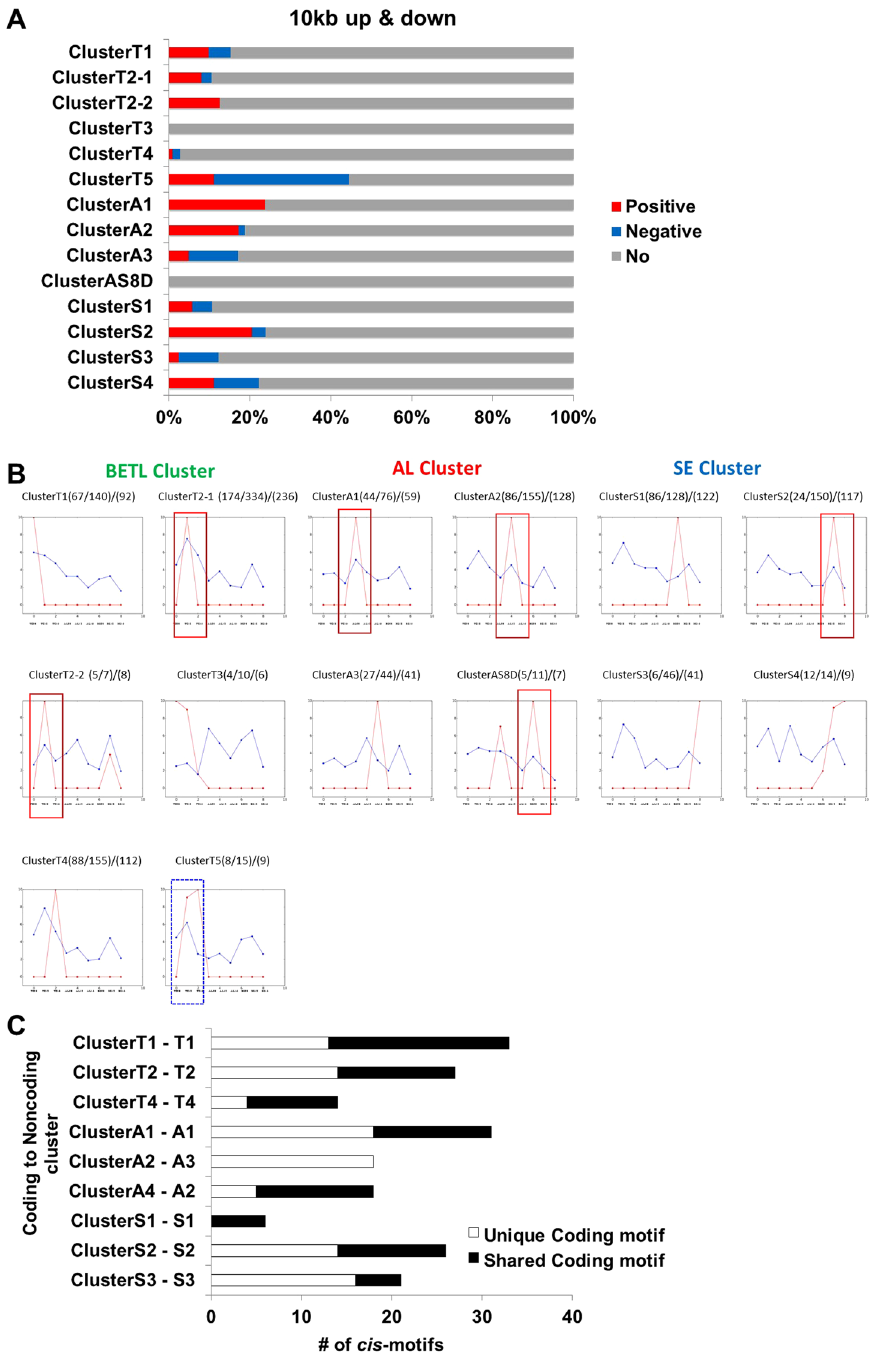
Figure 5. Co-regulatory relationships between noncoding and coding transcripts. ( A ) Correlations between expression of lncRNA and neighbouring coding genes within 10 kb upstream and downstream of lncRNAs transcript loci were calculated for lncRNAs in each cluster. ( B ) The median value of an expression of lncRNAs and their neighbouring coding genes in each cluster. The relative level of transcript is plotted on the y axis for each of nine samples: BETL08, BETL12, BETL16, AL08, AL12, AL16, SE08, SE12, and SE16 from left to right. Blue lines plot data for coding genes and red lines lncRNAs. Red boxes indicate positive correlations and blue box indicates negative correlation. ( C ) The number of enriched cis-regulatory modules between each SOM cluster of lncRNAs and coding genes showing similar expression